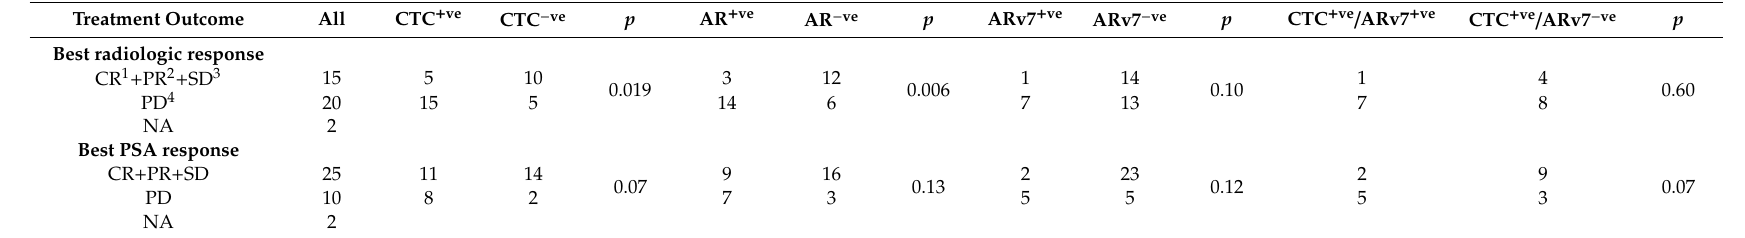
Table 2. Liquid biopsy variables according to best treatment